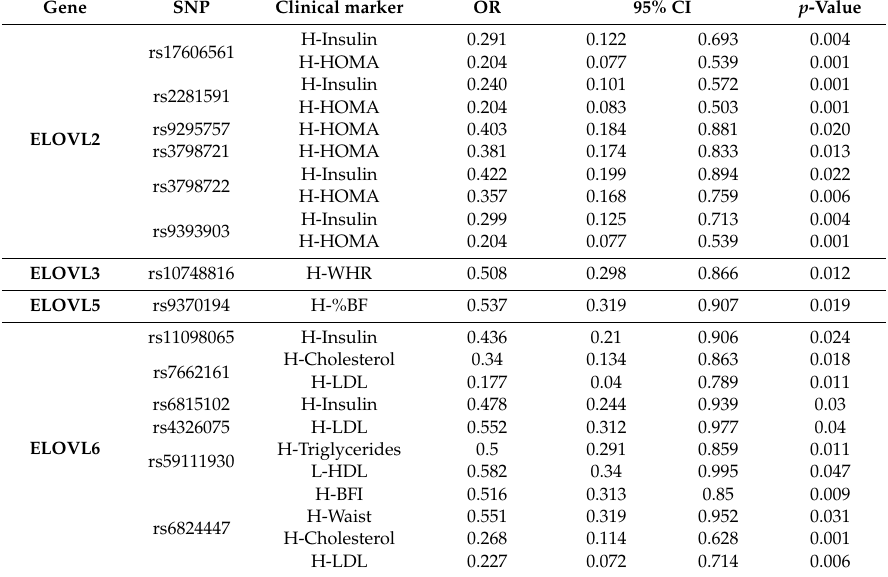
Table 9. Association of SNPs with clinical markers of chronic non-communicable diseases in men (protective